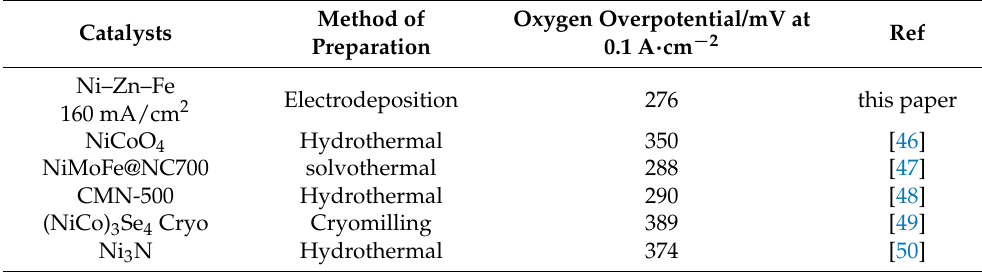
Table 4. Comparison of oxygen overpotentials between this study and the recently reported transition metal electrodes in OER(1 M KOH at 298